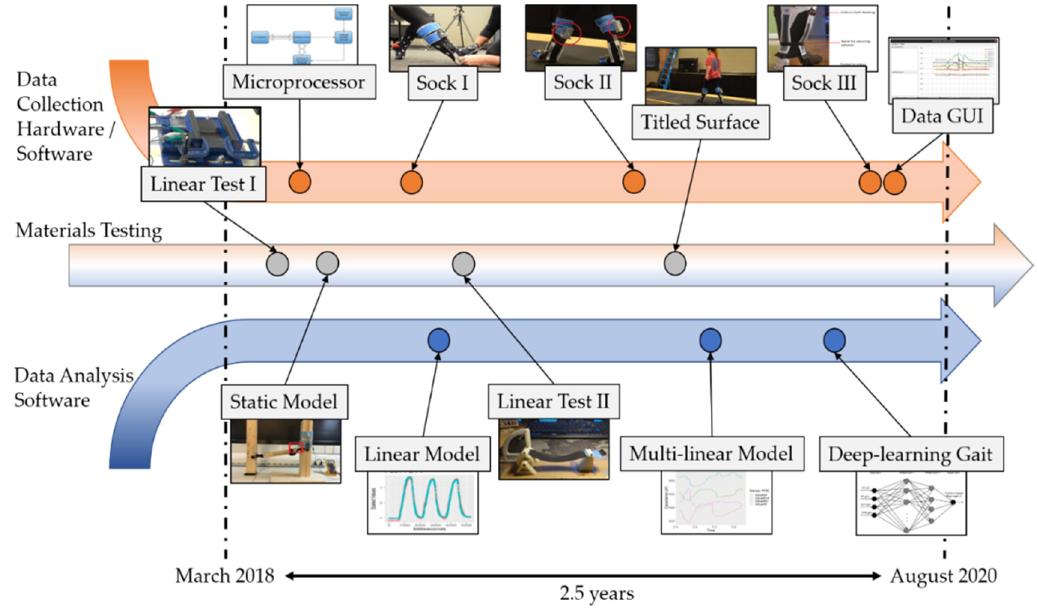
Figure 1. SSTK (stretch sensor tool kit) development timeline, depicting the three elements of SRS (soft robotic sensors) validation and SRS-based wearable development: materials testing, data analysis software, and data collection hardware/software.